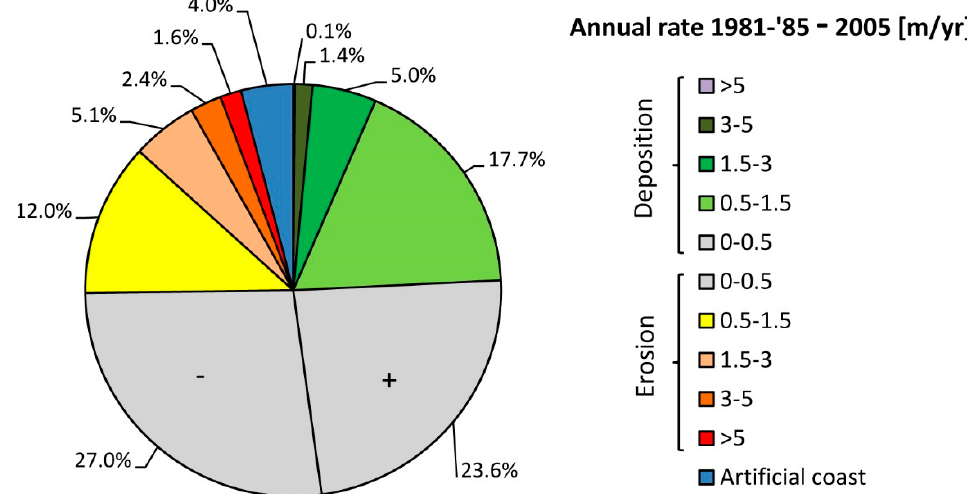
Figure 2. Synthesis of the shoreline displacement rate of the Tuscan coast from 1981–1985 to 2005 based on an unpublished report made by the University of Florence for the Tuscany Region.